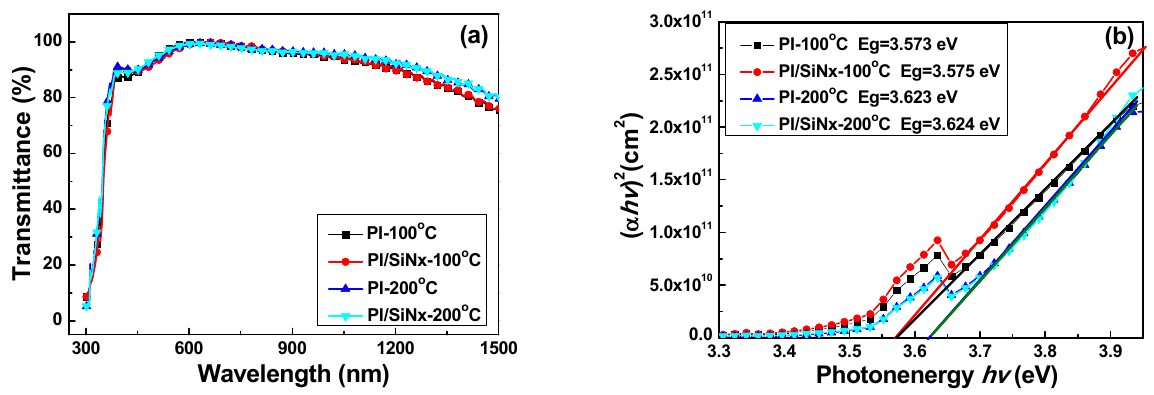
Figure 6. ( a ) Transmittance and ( b ) ( α hv ) 2 vs. h ν− E on different substrates as a function of deposition